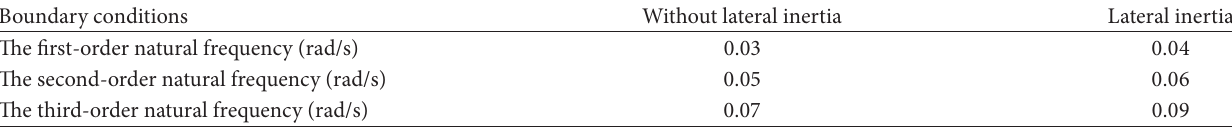
Table 6: The free vibration natural frequency in different